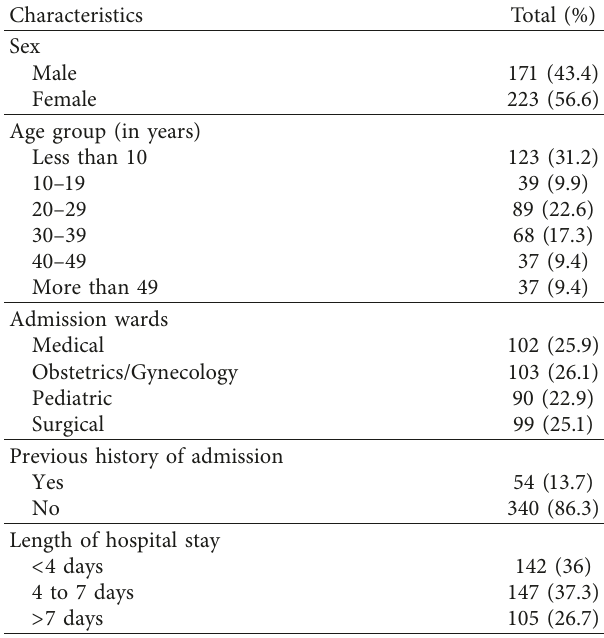
Table 1: Characteristics of NI-suspected patients at Hiwot